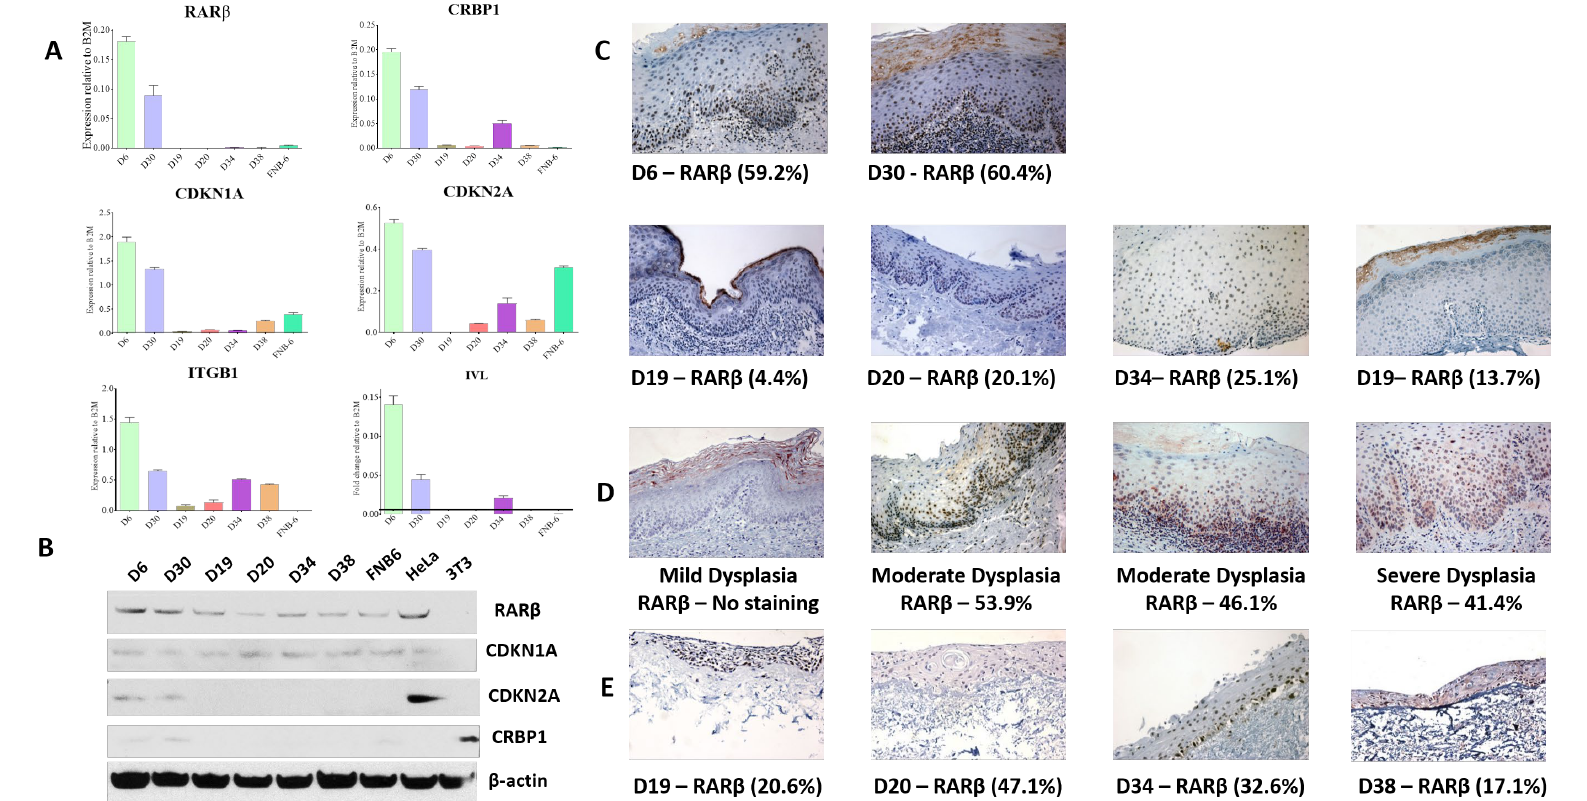
Figure 1. Baseline expression of RAR β 2 mRNA and total RAR β protein levels in PMOL cell lines and tissues. ( A ) Assessment of baseline RAR β 2 mRNA expression by qPCR demonstrated significantly higher expression in mPMOL cells (D6 and D30) compared to the iPMOL cells and FNB6TERT cells ( p < 0.03). The mRNA expression of cell cycle regulators, CDKN1A and CDKN2A, was also higher in the mPMOL cells when compared to iPMOL cells ( p < 0.002) and higher expression of cRBP1 and differentiation markers ITGB1 and IVL was also observed ( p < 0.05, Kruskal–Wallis test). ( B ) Western blotting of total RAR β , CDKN1A, and CDKN2A with β -actin as a loading control. HeLa cells and i3T3 cells were added as experimental controls. These show a similar pattern of expression to that seen in the qPCR, albeit the Western blot shows total RAR β , rather than RAR β 2. ( C ) Immunohistochemical expression of total RAR β in the FFPE biopsy tissues corresponding D6, D30, D19, D20, D34, and D38 showed lower RAR β expression in tissues from which iPMOLs were derived compared to those from which mPMOLs were generated. ( D ) Immunohistochemical expression of RAR β in the extended clinical cohort ( n = 10) demonstrated variable proportions of total RAR β expression, which was not related to the grade of epithelial dysplasia. ( E ) Immunohistochemical expression of RAR β in 3D TEM models constructed using iPMOL cells showed variable staining for RAR β , but in every case, higher than in the matched biopsy material (Figure